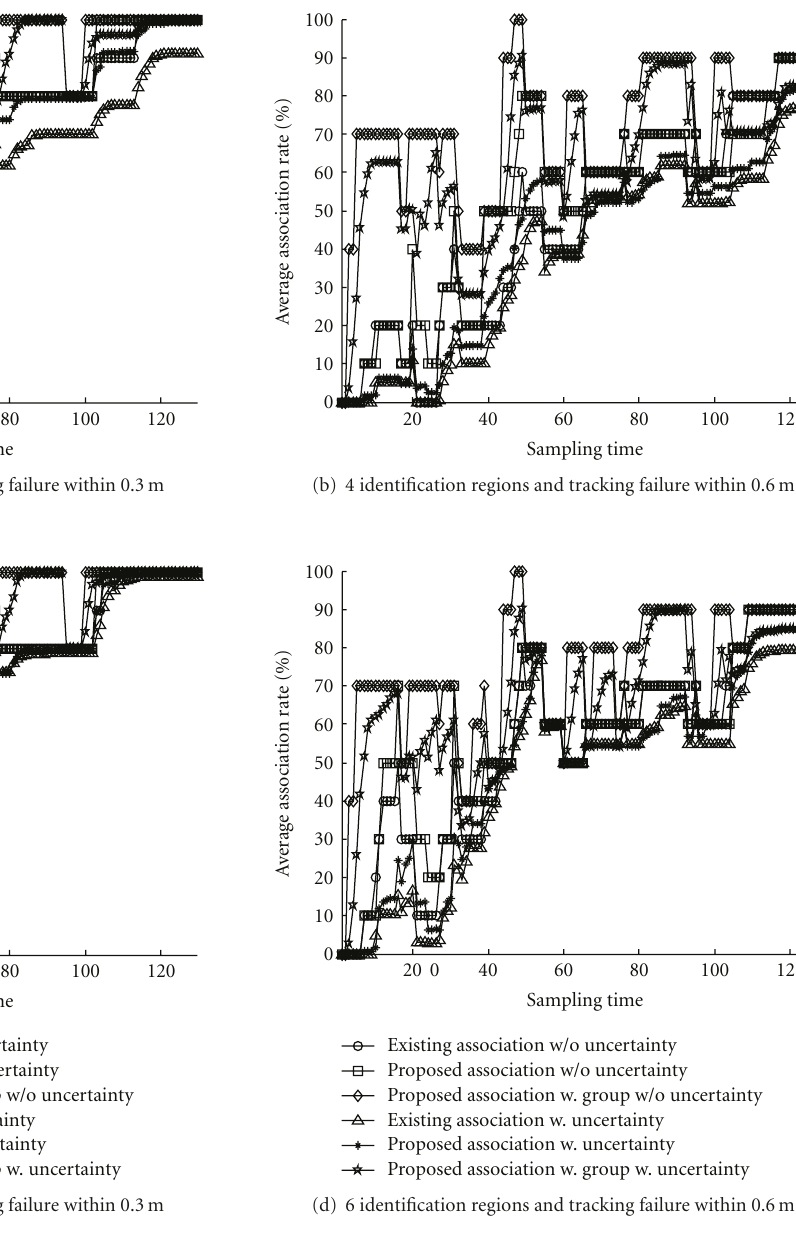
Figure 20: The simulation of association performance comparison in terms of the number of identification regions and the tracking